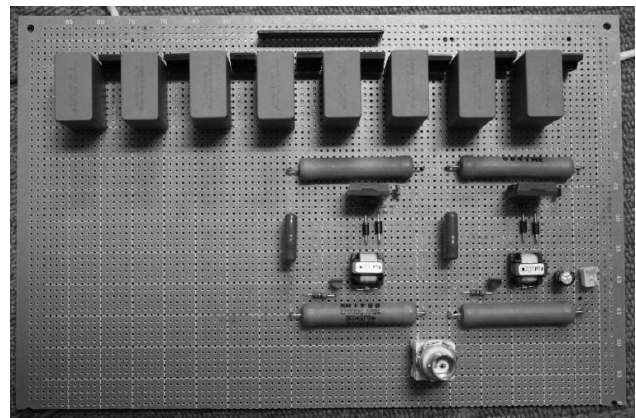
Figure 3. Image of the Marx Generator